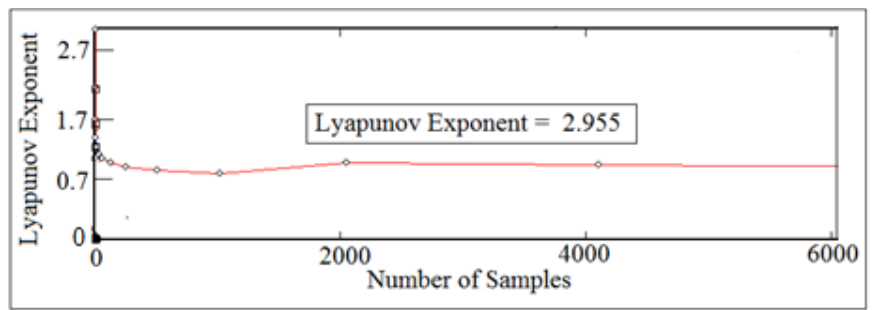
Figure 44. Local Lyapunov exponent against number of samples for (I.D. = 17 mm) and (N = 600 rpm).